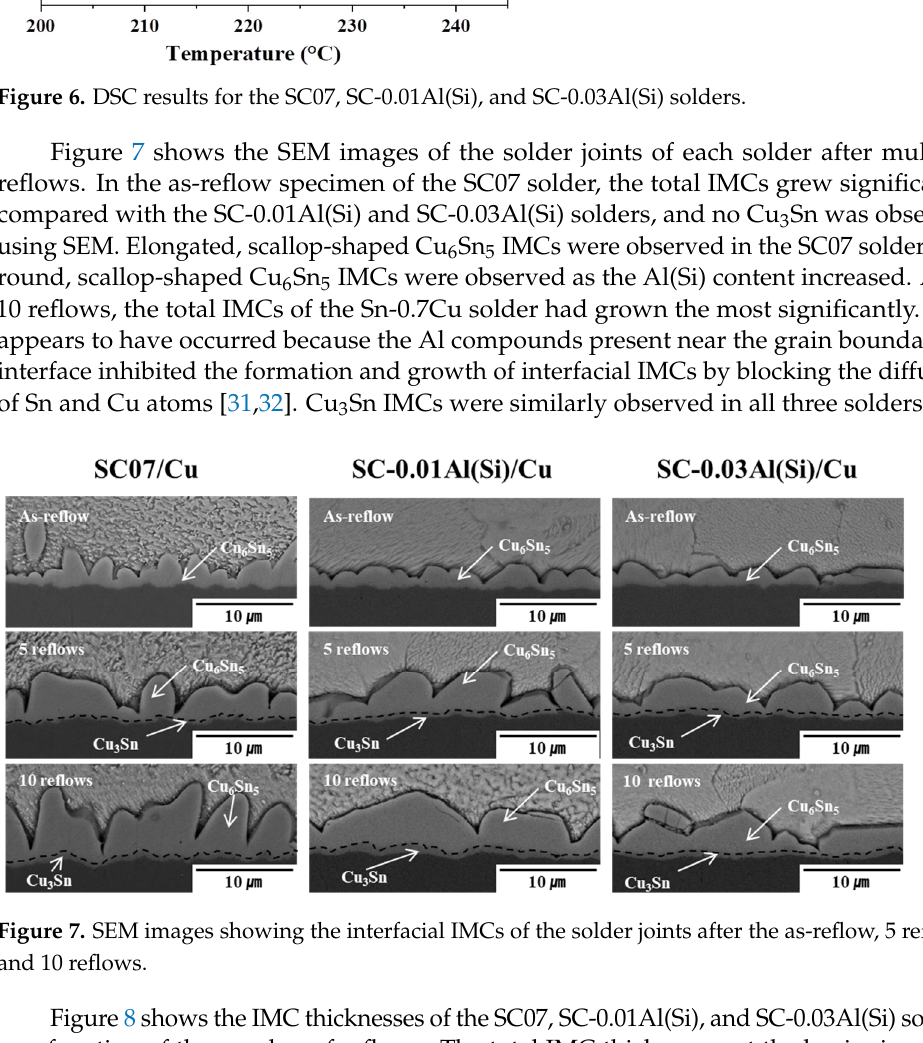
Figure 7. SEM images showing the interfacial IMCs of the solder joints after the as-reflow, 5 re- flows, and 10 reflows. and 10